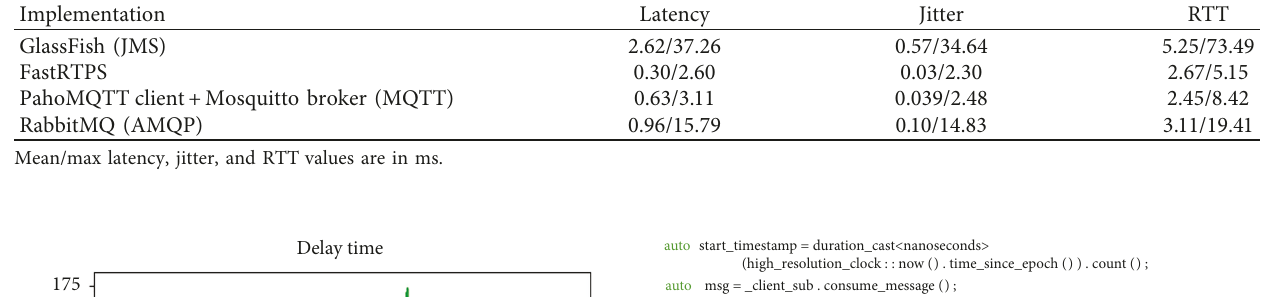
Figure 14: Measuring the execution time of the PahoMQTT library read function.